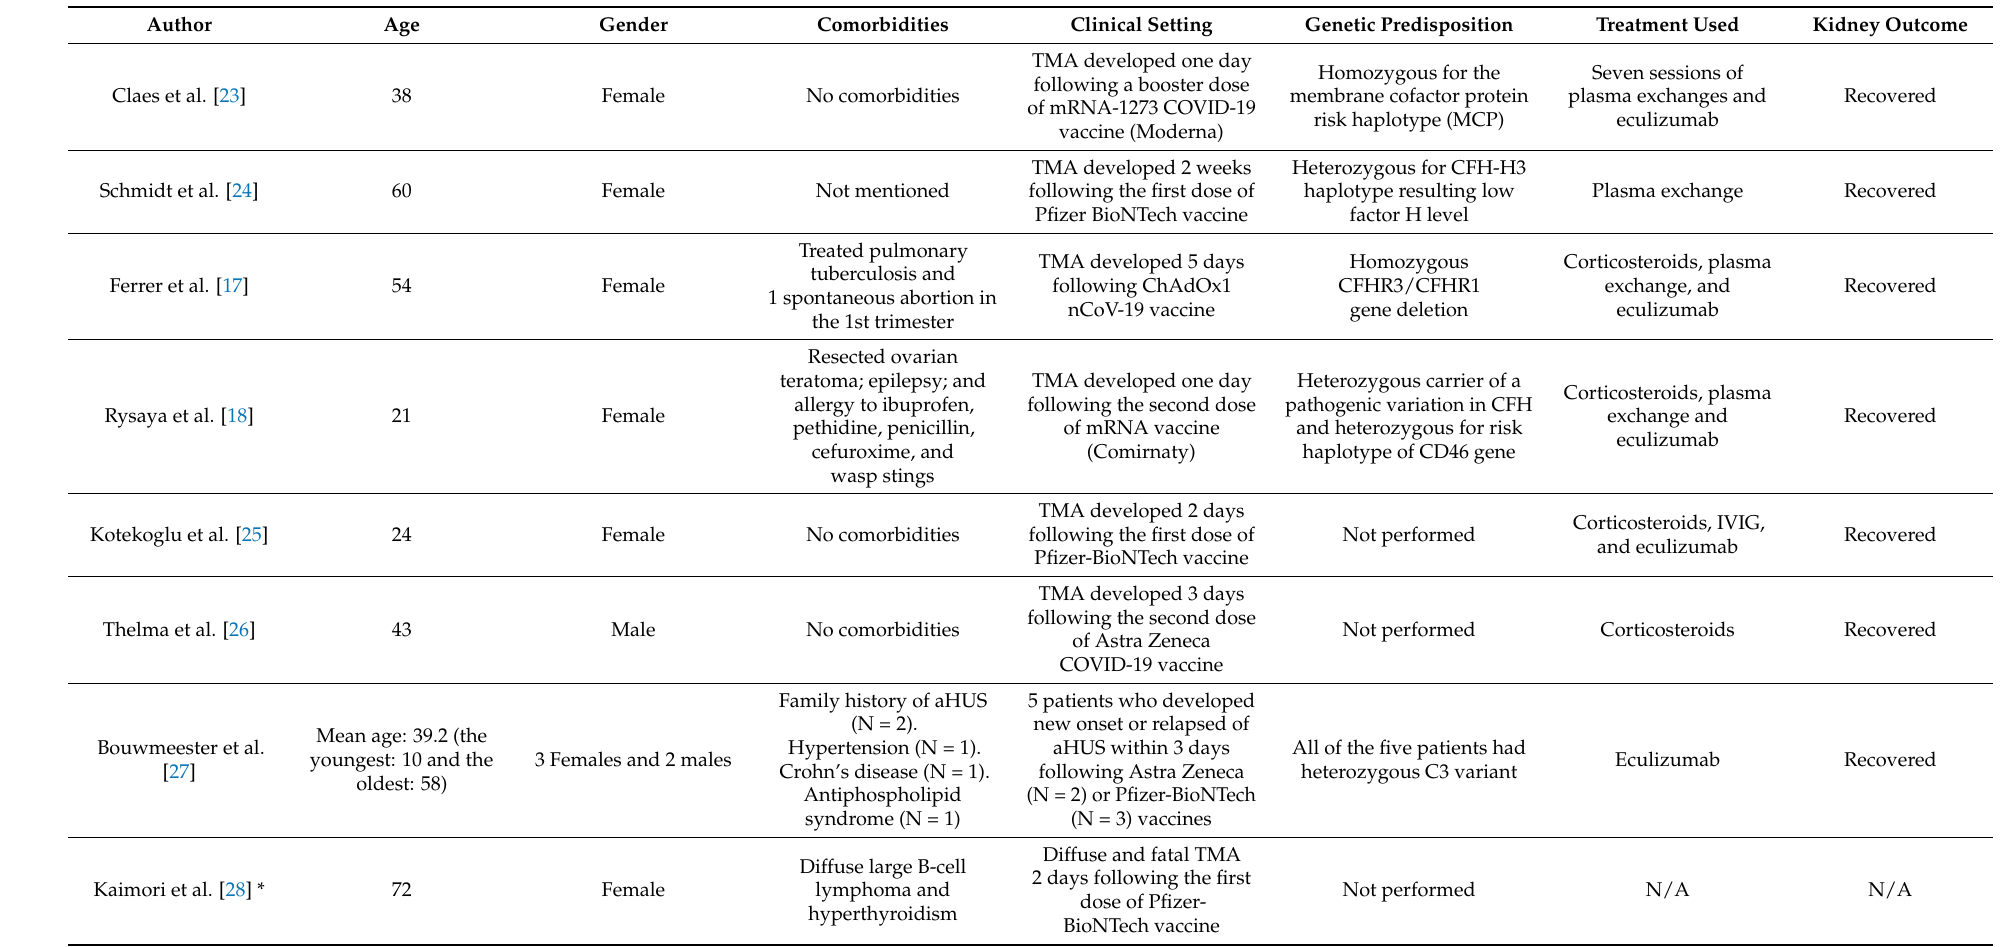
Table 2. Summary for the reported cases of TMA following SARS-CoV-2